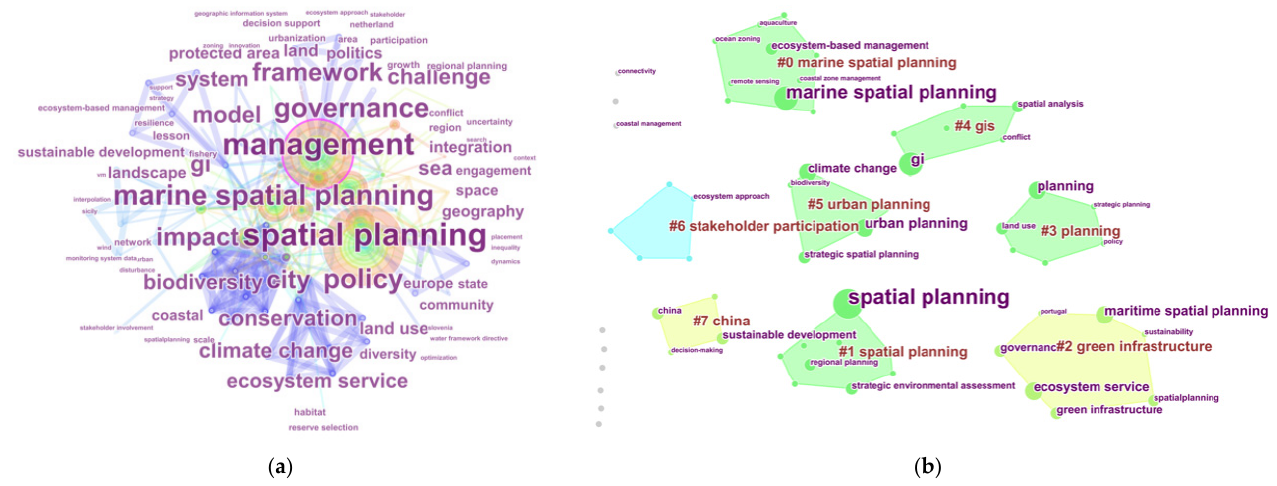
Figure 9. Visualization of keywords ( a ) and cluster analysis ( b ) (WOSCC).